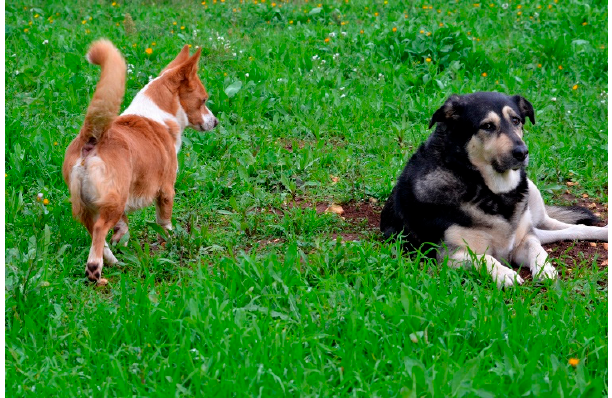
Figure 1. The female is looking at the little red male, asking him to increase the distance. The little red male is approaching in a curving but conflicting way; he has hackles and his face expresses tension. May be he is testing the reaction of the female, asking her to stand up; the female face expresses threat (she probably does not want to interact with him).